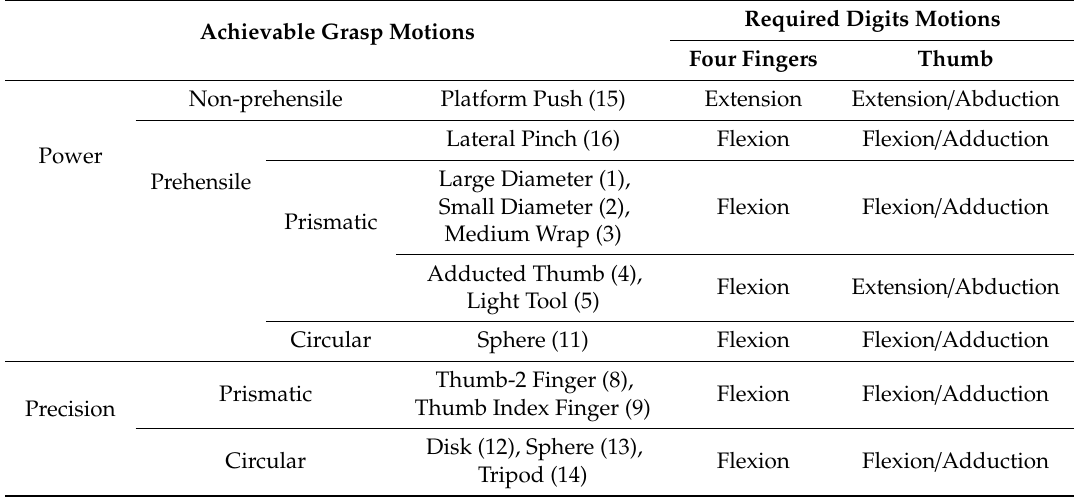
Table 1. Achievable grasp motions related to required digits motions (based on the Cutkosky taxonomy).